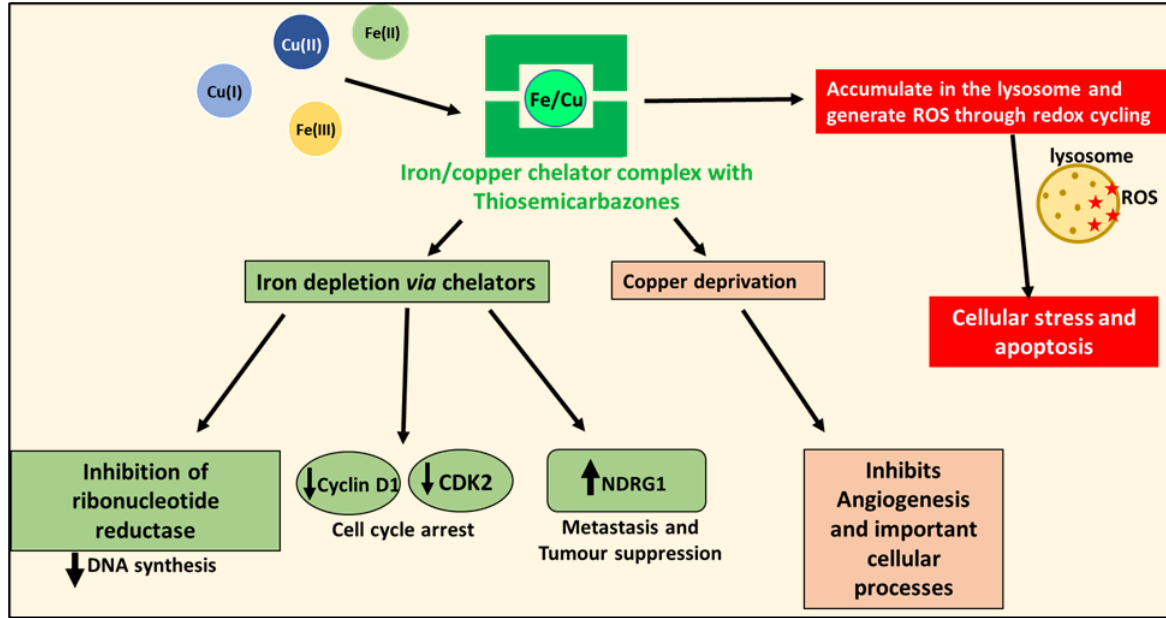
Figure 5. Anti-oncogenic effects of iron and copper-binding ligands. Metal chelators can deplete tumor cell iron and copper. This effect inhibits the iron-dependent enzyme, ribonucleotide reductase, that is required for DNA synthesis, as well as the expression of cyclin D1 and CDK2, resulting in cell cycle arrest. Iron depletion also increases the expression of the potent metastasis suppressor, NDRG1. These complexes also deprive cancer cells of the copper needed for angiogenesis and other crucial cellular processes. Additionally, some ligands — such as Dp44mT and DpC — form iron and copper complexes that accumulate in lysosomes and generate ROS, which leads to lysosomal membrane permeabilization and the apoptosis of cancer cells.